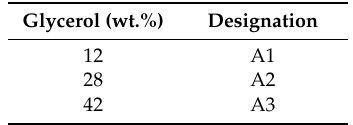
Table 1. Designation of the polymer electrolytes with di ff erent amount of glycerol. Glycerol (wt.%)